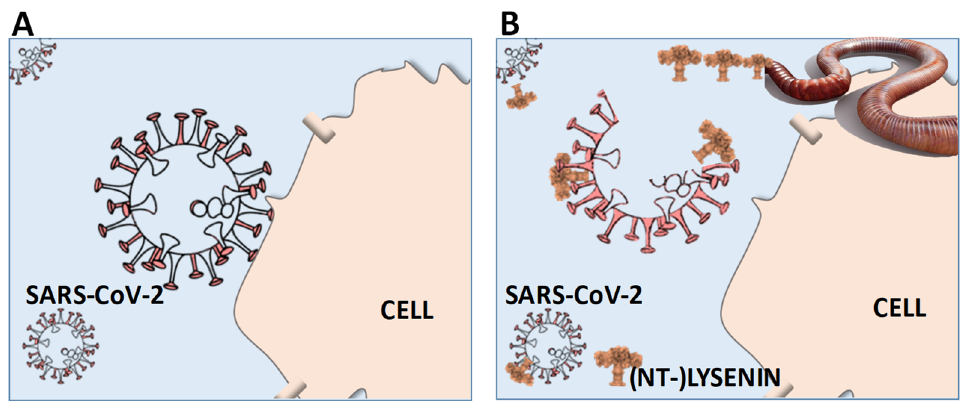
Figure 1. Schematic (hypothetical) outline of the therapeutic potential of lysenin (-derivatives) to prevent or treat human SARS-CoV-2 (COVID-19) infections. ( A ) No action: SARS-CoV-2 enters the organism and attaches to the cell membranes, allowing the RNA injection and infection. ( B ) (NT-)lysenin administration: SARS-CoV-2 enters the organism and encounters lysenin, which binds to sphingomyelin in SARS-CoV-2 envelope (corona), forming pores and disrupting it, hence no cell membrane attachment and, thus, no infection. (NT-)LYSENIN: Non-Toxic-Lysenin: representation of a modified lysenin derivative.